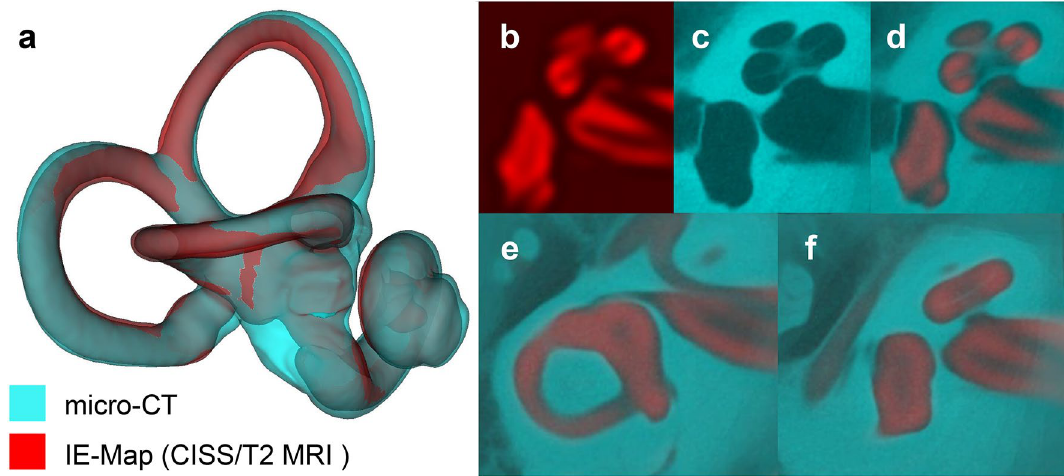
Figure 2. Validation of IE-Map morphology (red colormap) against an inner ear template built from 21 post- mortem CT and micro-CT scans (cyan colormap). Panels: ( a ) 3D surface models of the inner ear in CISS MRI and micro-CT, showing a high overlap of cochlear and vestibular dimensions and morphology. Note that both templates represent the average morphologies from two independent cohorts, and that templates were only rigidly registered to account for global position and rotation of overlap. ( b – d ). Axial slice through the cochlea in CISS, micro-CT and a semi-transparent overlay. Note that the gap between scala tympani and vestibuli in the CISS volume coincides with the spiral lamina visible in the micro-CT template. ( e – f ) Morphological congruency of the lateral SCC ( e ) and the vestibulum and basal cochlear turn ( f ) in T2 MRI and micro-CT. (Figure panels created with 3D Slicer, v4.11 (https ://www.slice